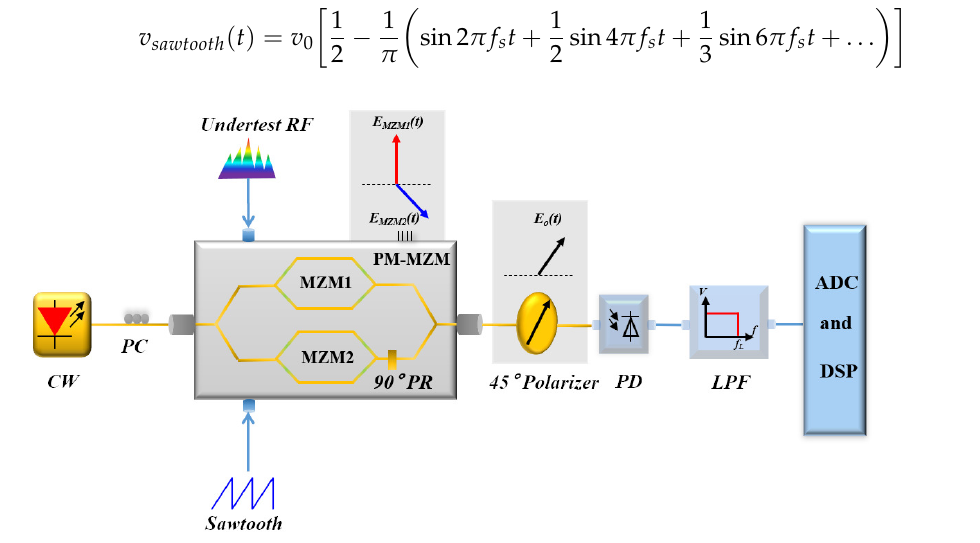
Figure 1. Schematic setup of the photonic MMFM system based on polarization interference and frequency converter. CW, continuous-wave laser; PC, polarization controller; RF, radio frequency; PM-MZM, polarization-multiplexing Mach–Zehnder modulator; PR, polarization rotator; PD, pho- todetector; and LPF, low-pass filter.